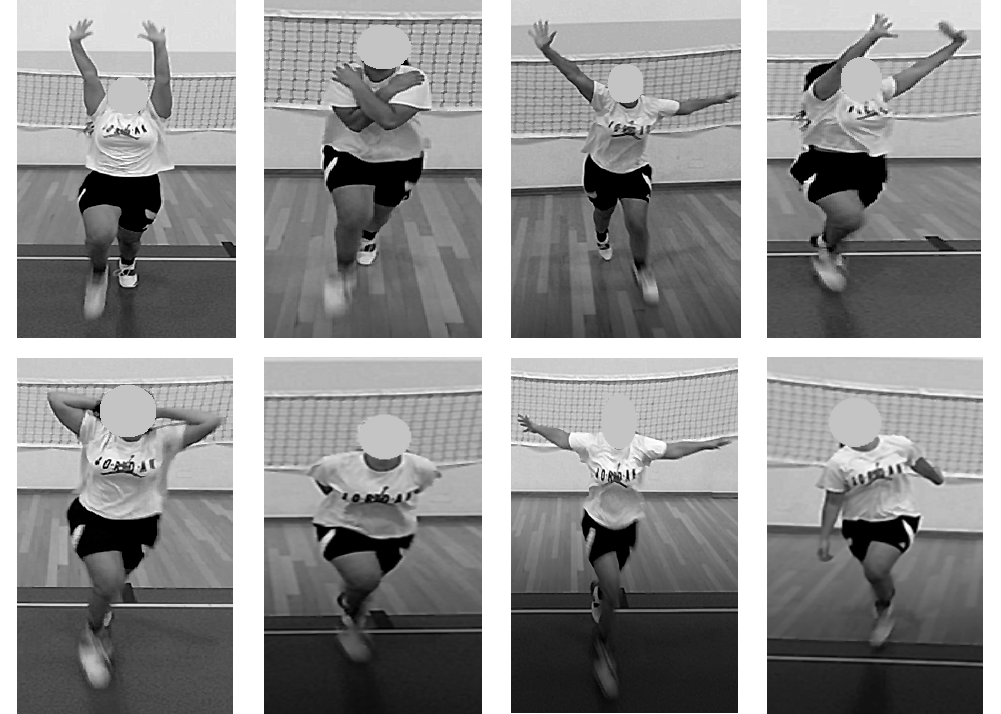
Figure 2. Examples of differential repeated sprint training fluctuations.